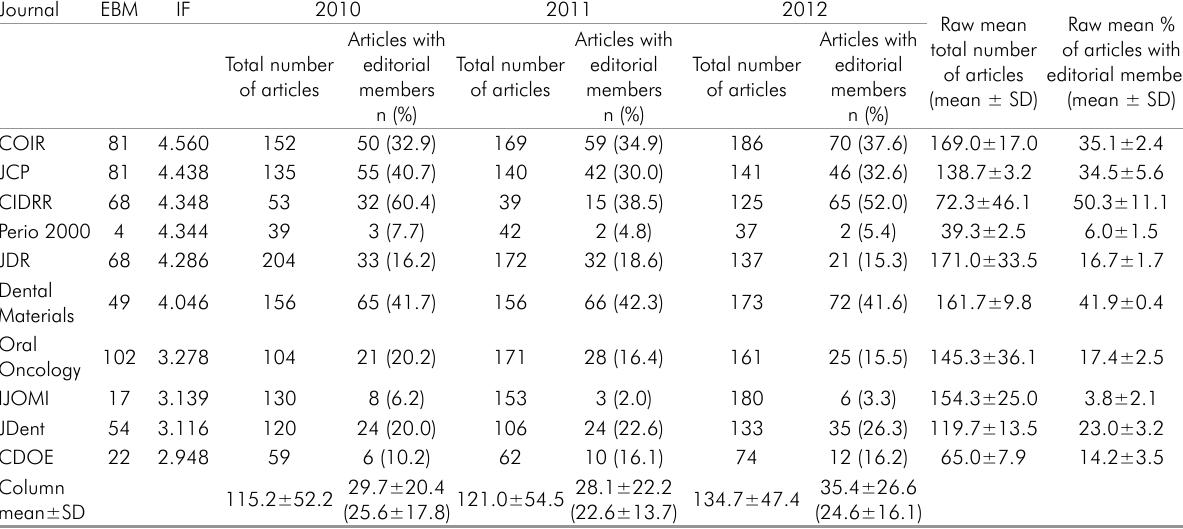
Table 1. Detailed information for each surveyed journal by year.